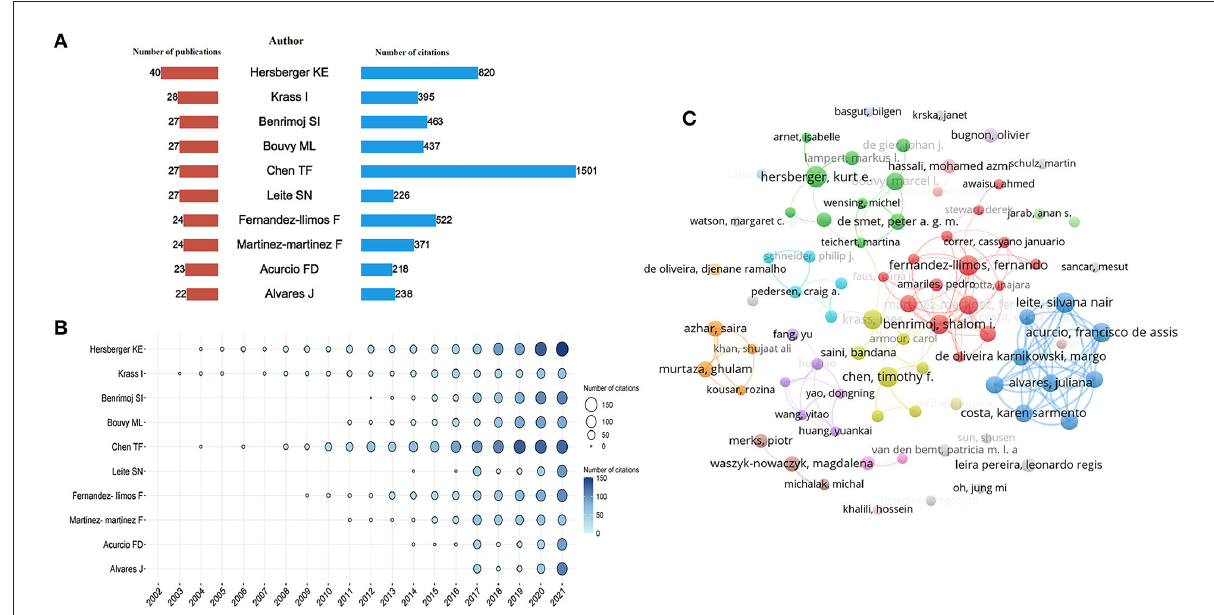
FIGURE5 Co-authorship analysis of authors. (A) Total Np and Nc of the top 10 authors. (B) The yearly Nc of the top 10 authors. (C) Cluster analysis of cooperation among authors with more than 8